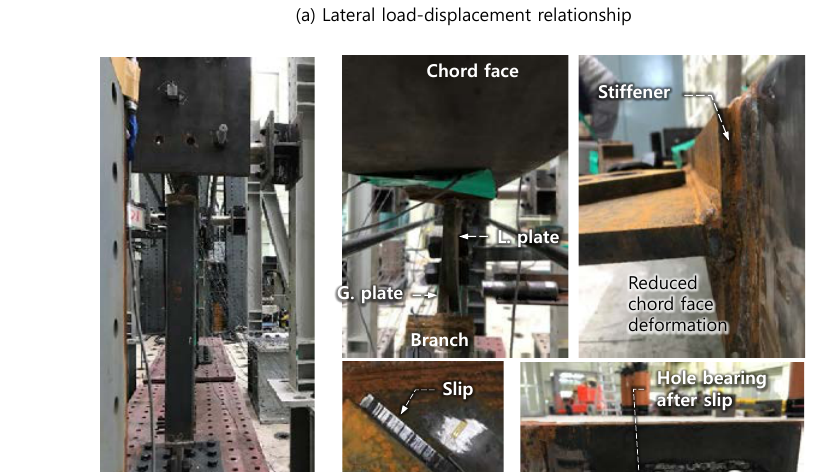
Figure 7. Test results of sti ff ened plate-to-RHS connection: S15-150: ( a ) Lateral load-displacement relationship; ( b ) Failure